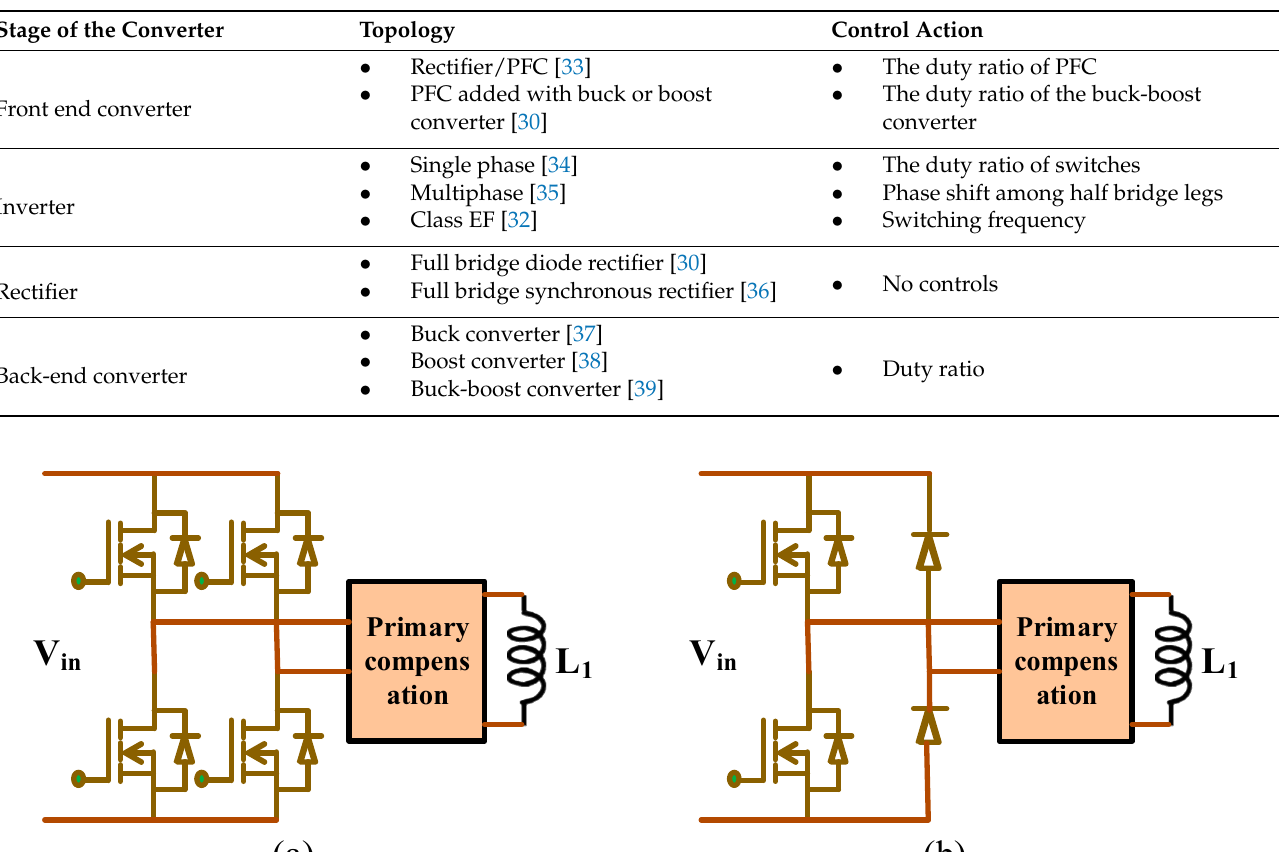
Table 2. At various stages of the converter.